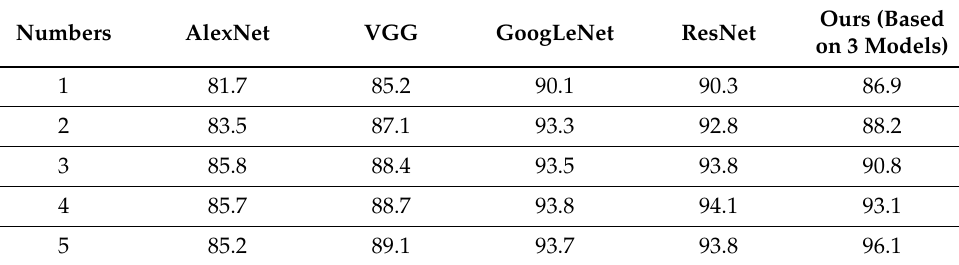
Table 9. Accuracy of different models with different client numbers.